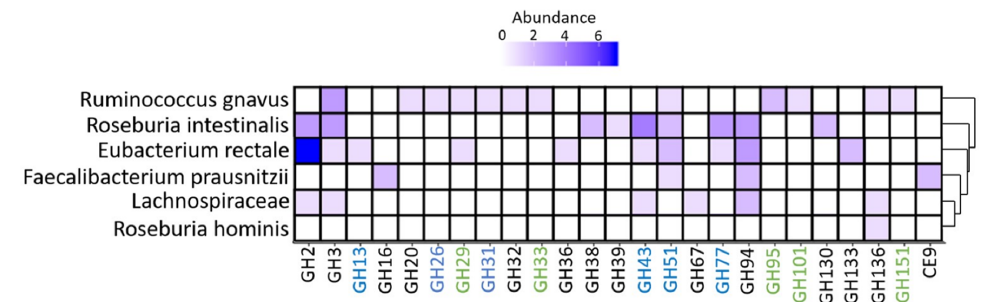
Figure 8. Expressed glycoside hydrolases / carbohydrate esterases. The figure shows proteins expressed within the glycoside hydrolase and carbohydrate esterase groups expressed based on the contiguous sequences assembled from shotgun sequencing and protein expression derived from nanoLC-Orbitrap tandem mass spectrometry (MS / MS). The abundance represents the number of unique proteins expressed from a given taxa within the glycoside hydrolases (GH) or carbohydrate esterase (CE) group. The y-axis shows the relevant taxonomies, and the dendrogram represents the Euclidian distance between the taxonomic groups based on GH and CE expression. The plot was created using ggplot2 [18]. GH numbers related to mucus and fucose degradation are marked in green, and degradation of starch, glycogen, and hemicellulose are marked in